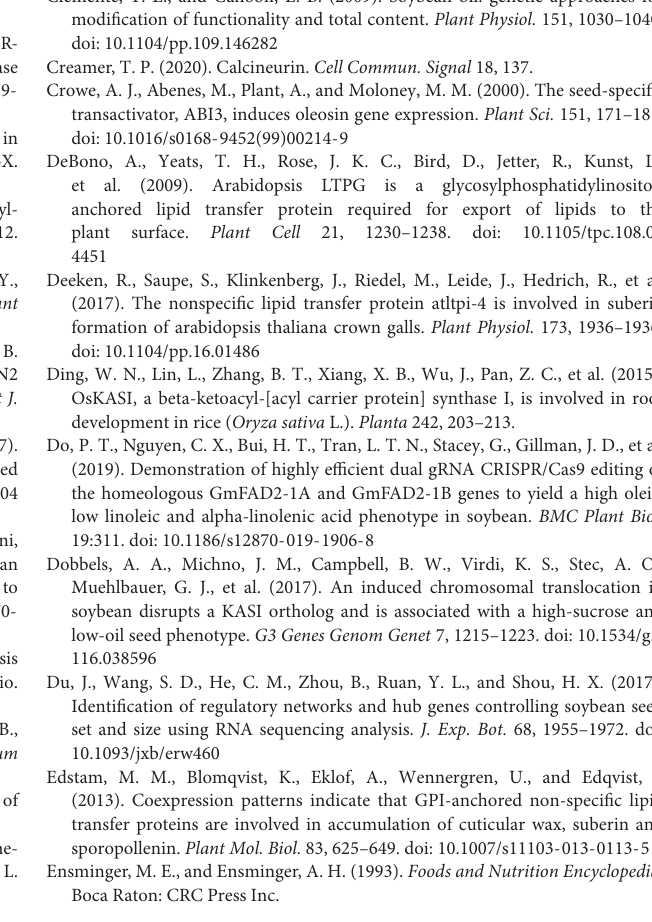
Supplementary Figure 1 | Global gene expression profiling of HO and LO. Supplementary Figure 2 | Heatmap comparison of the trait-specifical module genes. Supplementary Table 1 | The DEGs at three developmental stages. Supplementary Table 2 | The gene specific primers for qRT-PCR. Supplementary Table 3 | The fatty acid profiles of HO and LO at different stage. Supplementary Table 4 | Gene Ontology analysis of trait-specifical module. Supplementary Table 5 | Kyoto Encyclopedia of Genes and Genomes (KEGG) enrichment analysis of three modules. Supplementary Table 6 | Genes of “plasma membrane” and “monolayer-surrounded lipid storage